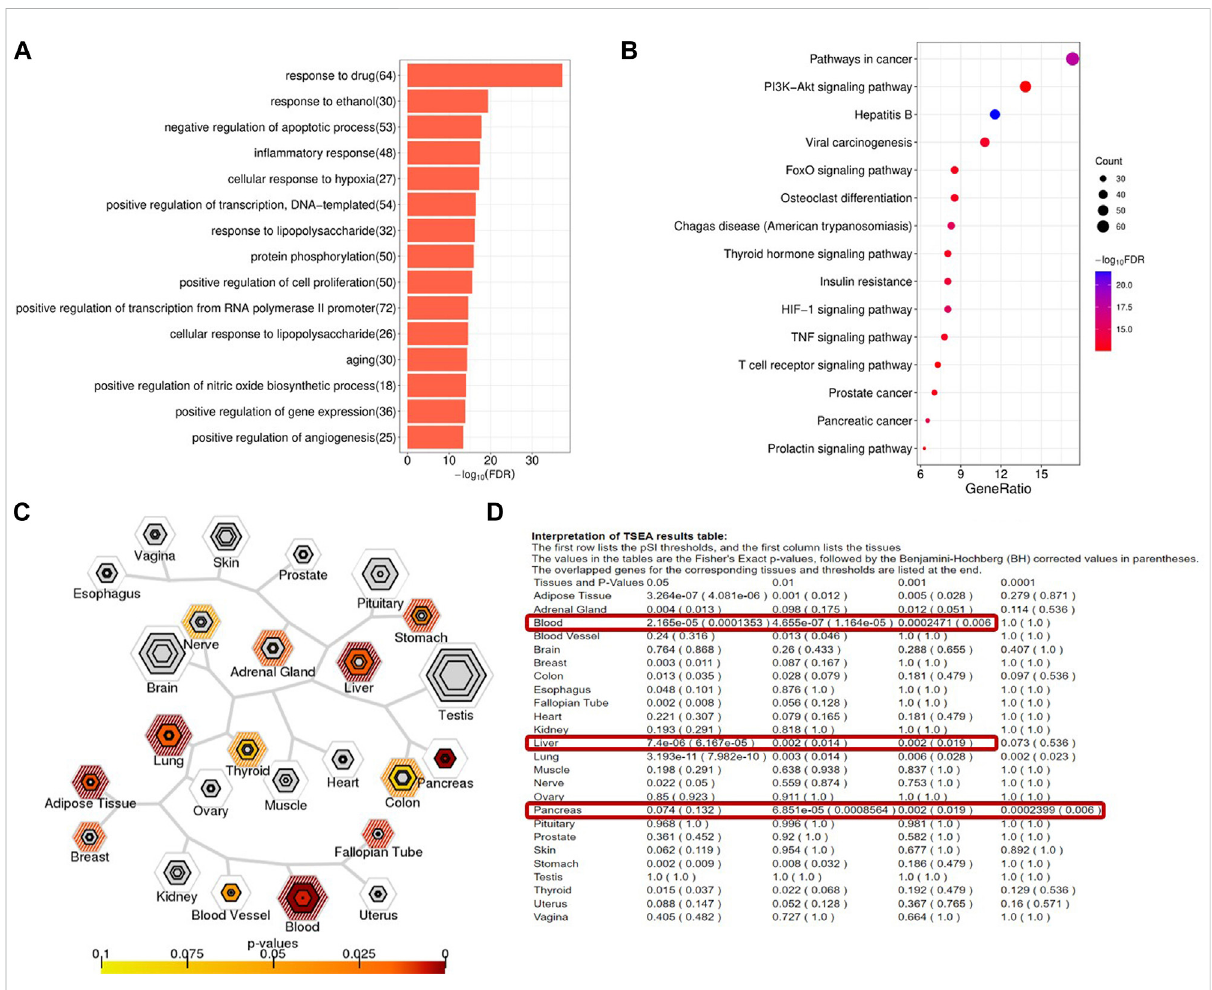
FIGURE 3 Functional enrichmentandtissueenrichmentoftheYXQNWcompoundtargets. (A) GOanalysis; (B) KEGGanalysis; (C) TSEAanalysis; (D) tissue